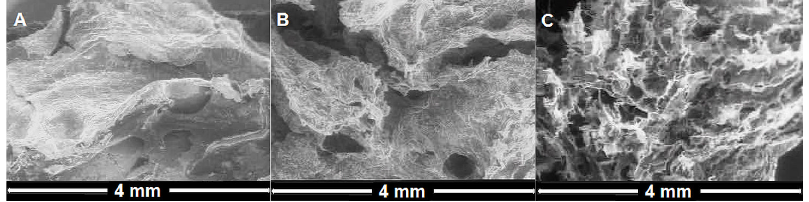
Figure 1. Characteristic micrographs (typical microstructures) for the CP7 sample prepared under different conditions: ( A ) 37 °C, final dispersion concentration 1.25%, ( B ) − 12 °C, final dispersion concentration 1.25%, and ( C ) − 12 °C, concentration of reaction medium 2.4%. concentration 1.25%, and ( C ) − 12 ◦ C, concentration of reaction medium